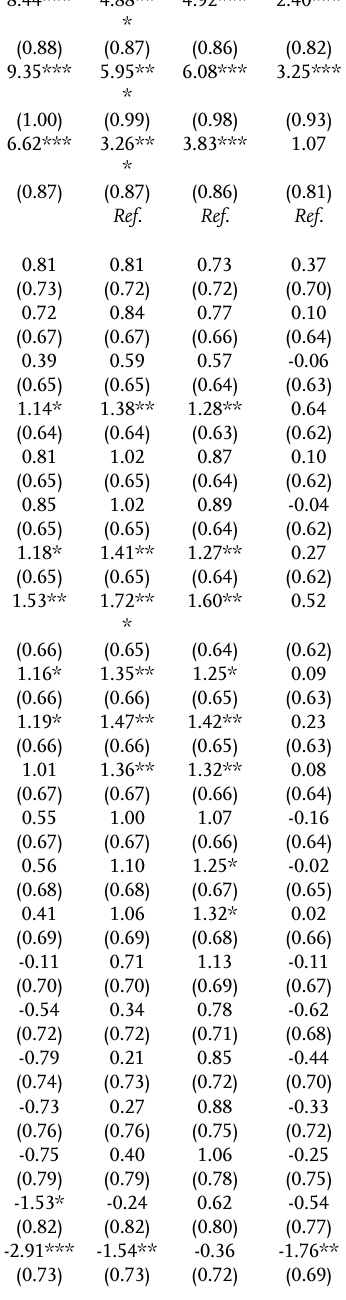
Table A.1 : Earned income, spacing and interaction terms (continued) Mothers age